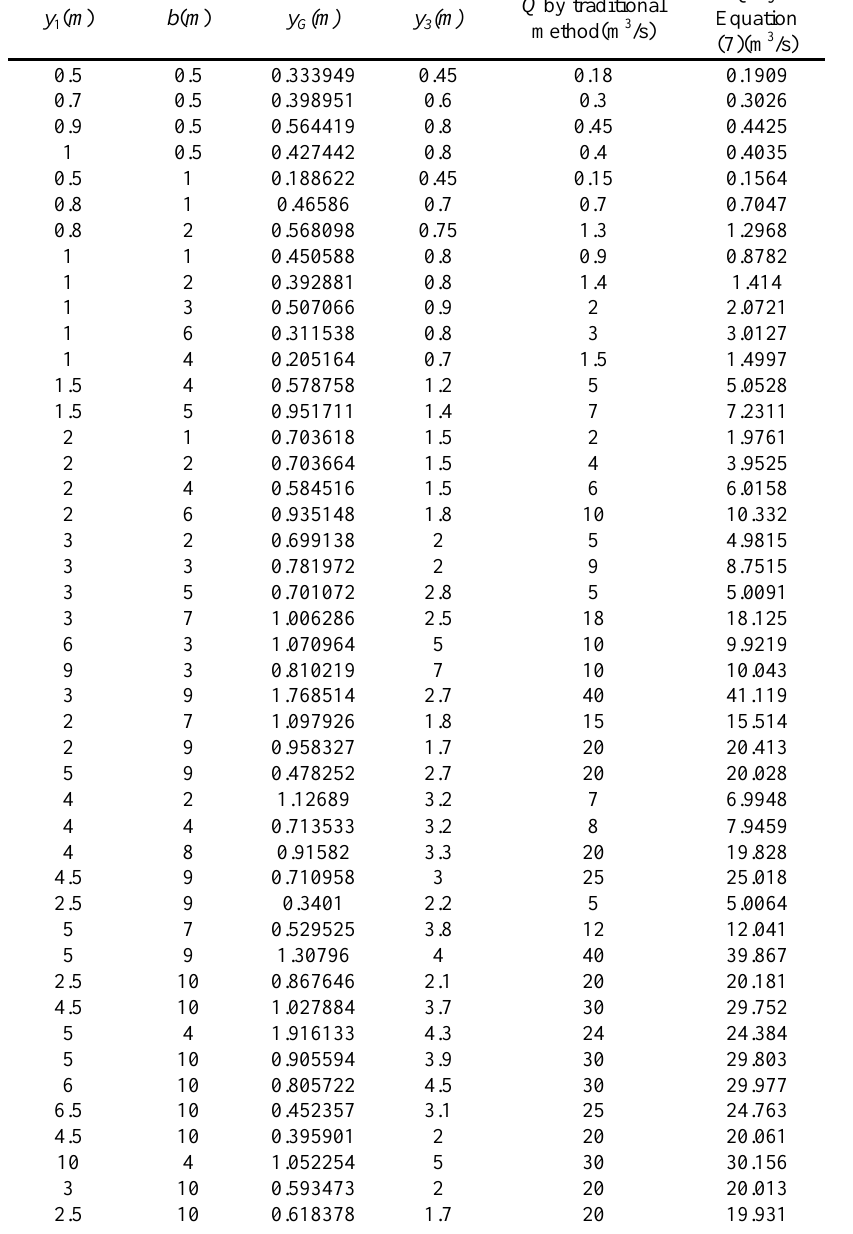
Table 2. Comparison of the discharges obtained by the traditional method and Equation